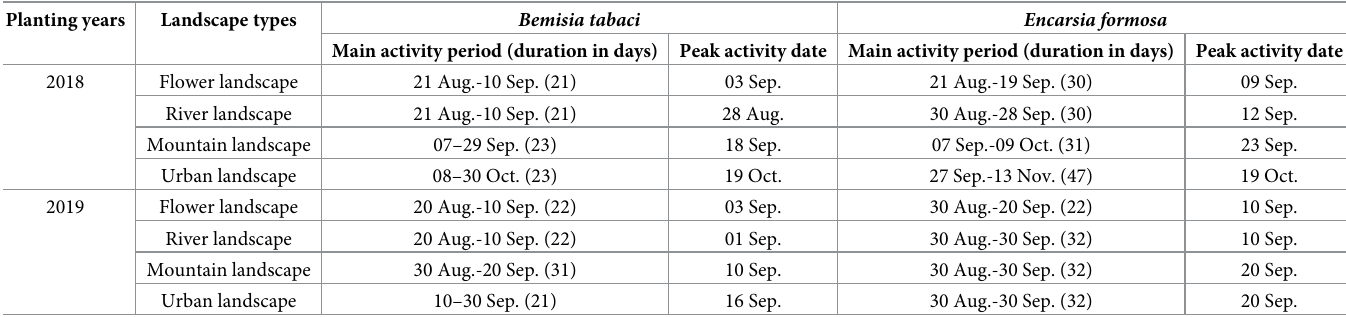
Table 3. Main activity periods and peak activity dates of Bemisia tabaci adults and Encarsia formosa in different types of landscapes in Kunming, south China. Planting years